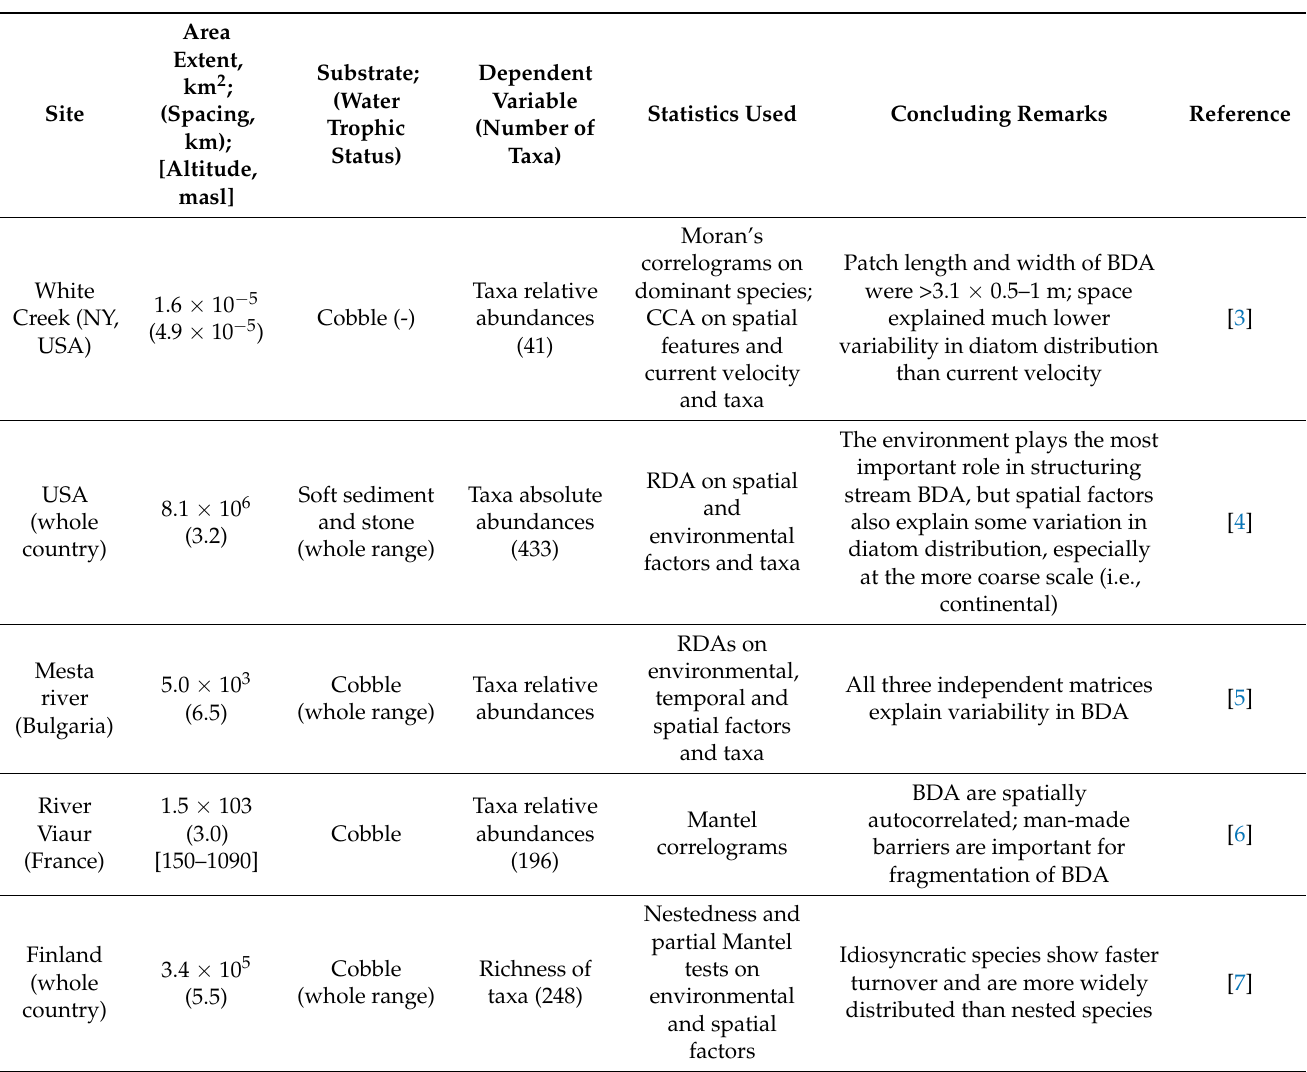
Table 1. Main results reported for metacommunity analyses of benthic diatom (BD) communities worldwide. The lag or spacing (km) was estimated as the square root of geographical extent scaled by the number of sampled sites. ANOSIM: ANOVA of similarities; CCA: canonical correspondence analysis; DBMEM: distance-based Moran’s eigenvector maps; DCA: detrended correspondence analysis; DBRDA: distance-based RDA; LCBD: local contribution to beta diversity; LM: lineal